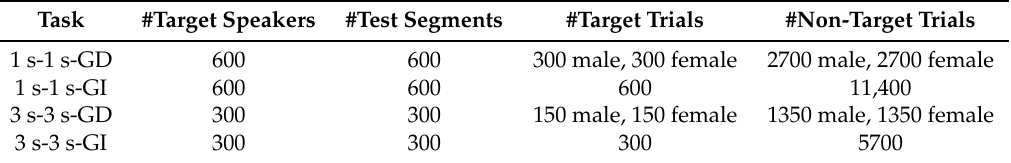
Table 2. Text-dependent short-time ASV task